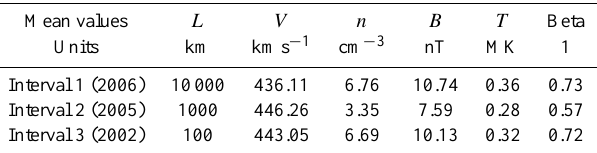
Table 1. Mean values of plasma and magnetic field data in the three analyzed intervals: Characteristic tetrahedron size of Cluster L , flow speed V , ion number density n , magnitude of magnetic field B , ion temperature T , and the plasma parameter beta.